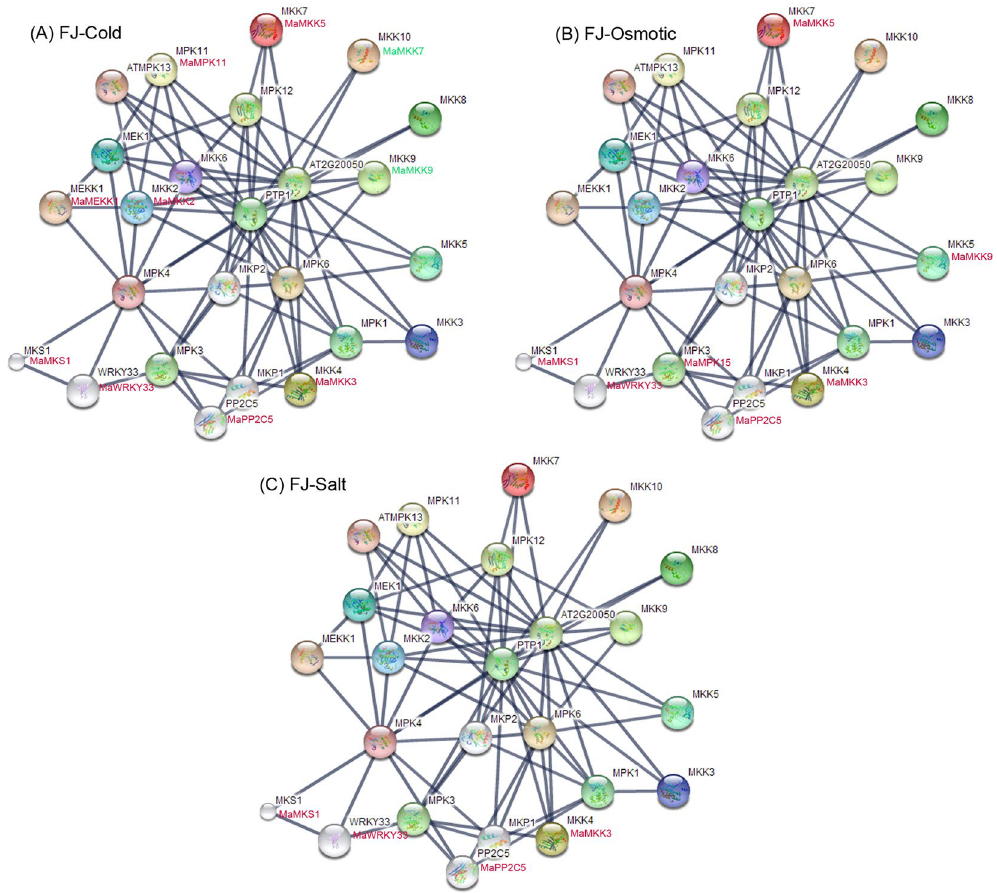
Figure 13. Interaction network and co-expression analyses of banana MAPKKK-MAPKK-MAPK cascades after cold, osmotic and salt treatments in FJ and related genes in Arabidopsis. The homologous genes of banana are in parentheses. The genes marked with red show significant upregulation (Log2 based FPKM value > 1 and P -value < 0.05). The genes marked with green show significant downregulation (Log2 based FPKM value < − 1 and P -value <